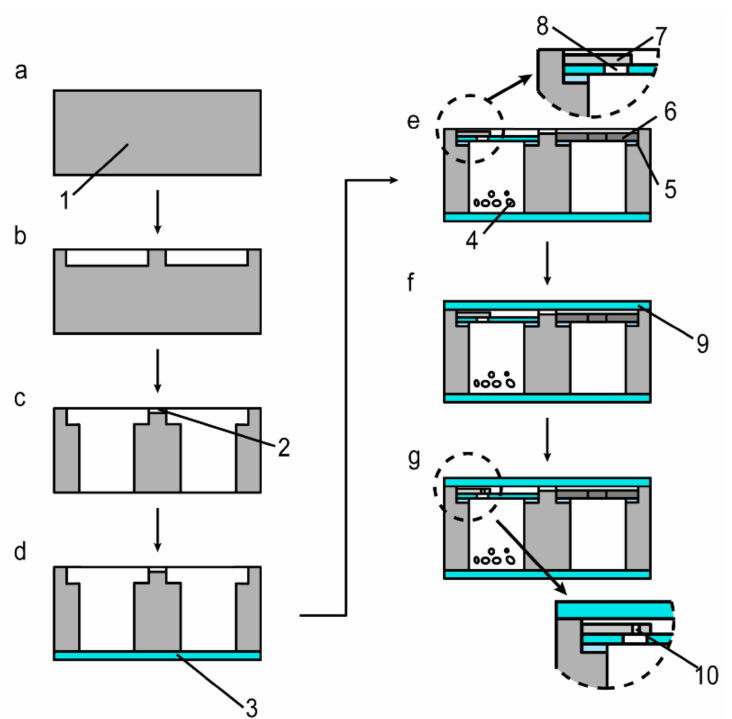
Figure 6. Preparation process of the MEMS microparticle vacuum chamber (1: Silicon wafer, 2: Micro- channels, 3: Lower glass sheet, 4: Vaterite particles; 5: High temperature adhesive; 6: Cantilever resonator; 7: Tinfoil; 8: Small glass sheet with one hole; 9: Upper glass sheet; 10: Micropore in the tinfoil). ( a – g ) refer to each processing step. See the text for its specific